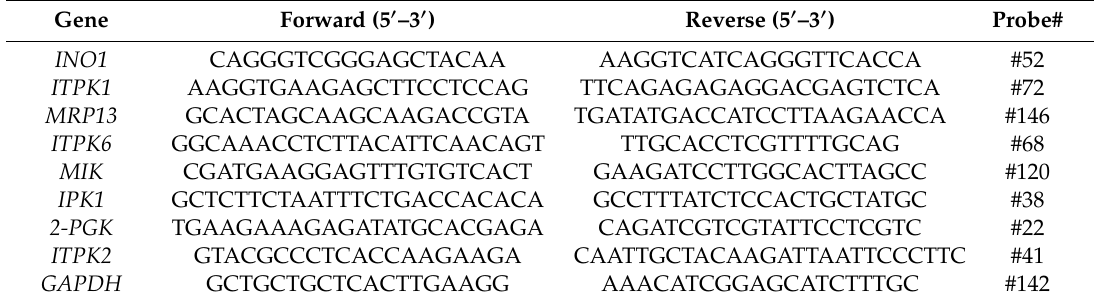
Table 4. List of primer and probes used in the gene expression